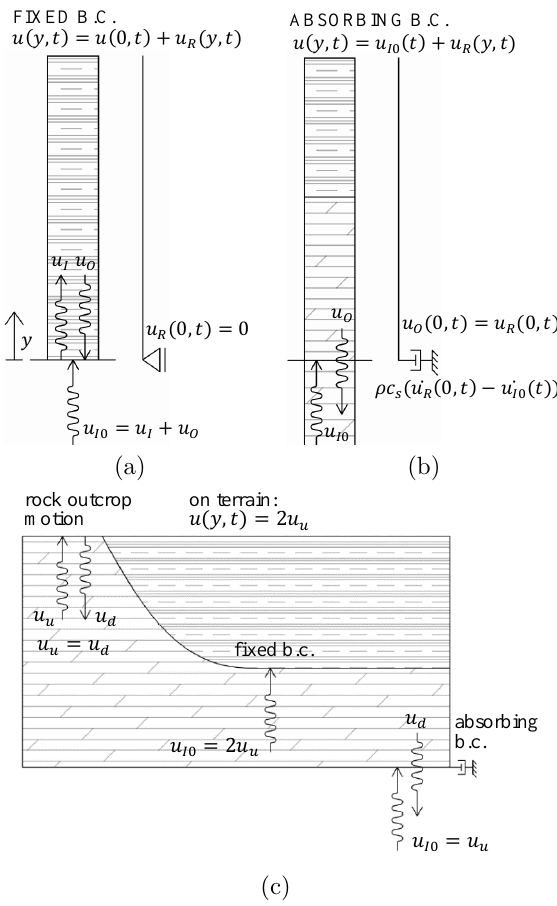
Figure 4. a) Free field column with fixed boundary, b) Free field column with absorbing boundary, c) Loading and boundary